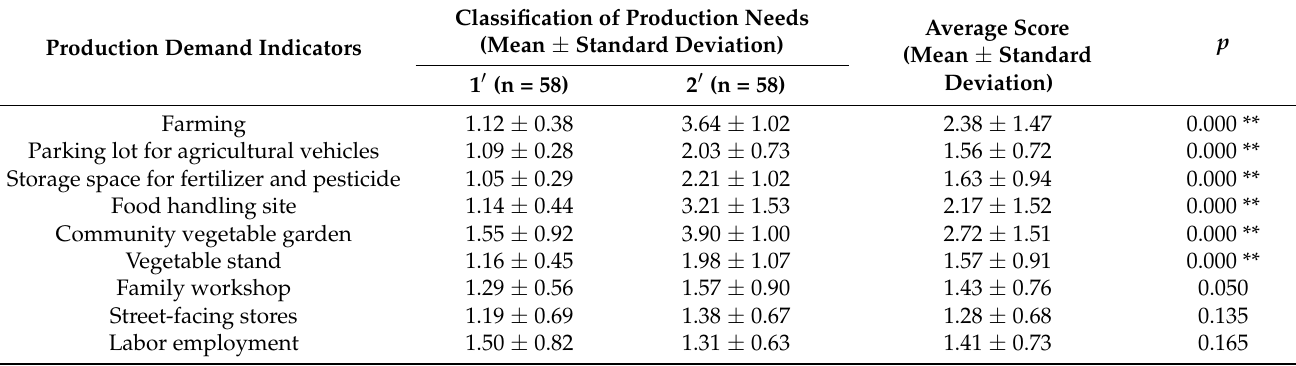
Table 4. Characteristic variables of production needs and One-Way ANOVA test (Source: